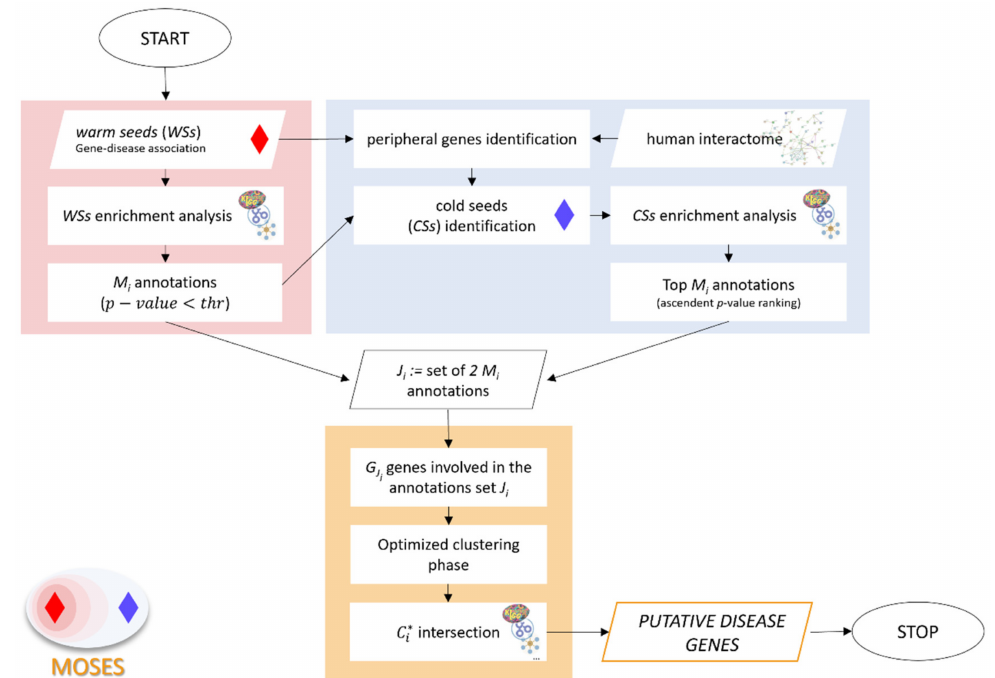
Figure 2. Flowchart of MOSES algorithm. The background rectangles identify the three sequential phases: red, blue and orange respectively for: (1) WSs functional characterization, (2) CSs iden- tification and characterization, and (3) optimized clustering phase. The enrichment analysis can be performed considering different types of gene annotations (Gene Ontology database, KEGG pathways, miRTarBase) and obtaining for each of them M i annotations, with i = GO; KEGG; miRTar- Base,